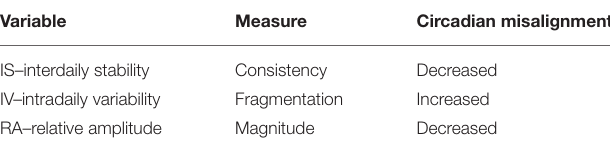
TABLE 2 | Circadian rest –activity non-parametric